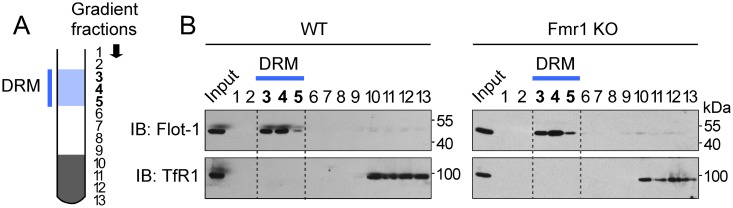
Purification of lipid raft enriched membranes from wild type and Fmr1 mutant mouse brain.A) Schematic of isopycnic sucrose gradient used in isolation procedure of detergent resistant membranes (DRMs). Light gradient fractions containing DRMs (fractions 3 to 5) and heavy gradient fractions containing non-raft proteins are indicated. B) Representative immunoblots of extracts from WT and Fmr1 KO mouse brain illustrating isolation of DRMs used for proteomic studies. Numbers above gel lanes indicate gradient fractions (#1, first fraction; #13, bottom gradient fraction). Input, total homogenate; Flot-1, Flotillin-1; TfR1, Transferrin receptor 1; IB, immunoblot.